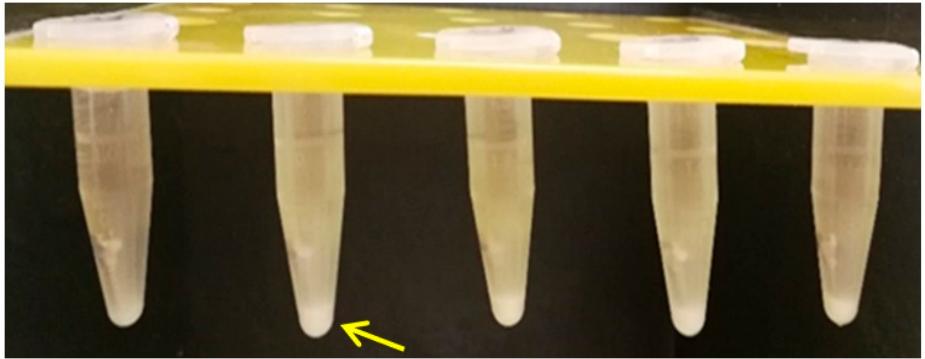
Figure 10. Bacterial proliferation— Porphyromonas gingivalis (PG) culture.